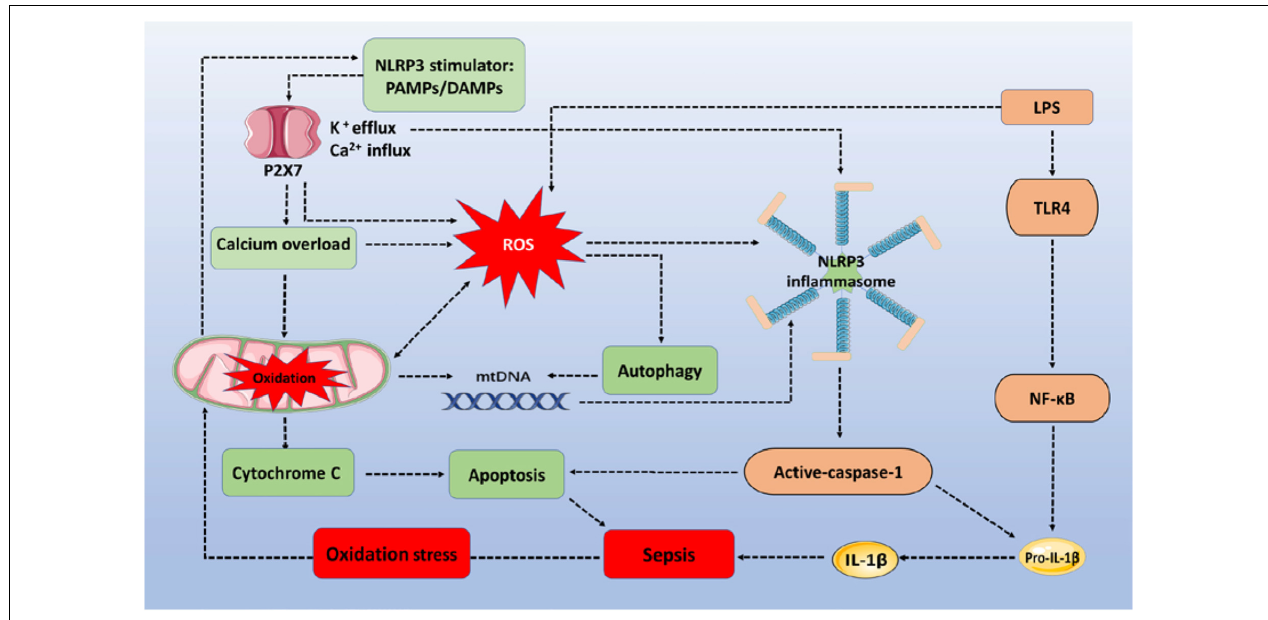
FIGURE 1 | The ROS/NLRP3 signaling pathway participates in sepsis-related immune responses. The sepsis associated oxidative stress induces ROS generation via oxidation of mitochondria. PAMPs/DAMPs trigger P2X7 activation and promote Ca 2 + influx and K + efflux. Increased Ca 2 + influx (calcium overload) and ROS destroy the stability of mitochondria, triggering mtDNA and cytochrome C accumulation within the cytoplasm, to assemble NLRP3 inflammasomes and induce apoptosis. LPS activates TLR4/NF- κ B signaling to express pro-IL-1 β and pro-IL-18. Activated caspase-1 then cleaves pro-IL-l β and pro-IL-18 into their mature forms to increase the inflammatory response. In addition, NLRP3 inflammasomes depend on caspase-1 to mediate immune cell apoptosis. During the whole process, autophagy is activated by ROS to clear mtDNA, and to partially reduce NLRP3 inflammasome activation. ROS, reactive oxygen species; NLRP3, NOD-, LRR-, and pyrin domain-containing protein 3; TLR4, toll-like receptor 4; LPS, lipopolysaccharides; PAMPs/DAMPs, pathogen-associated molecular patterns and damage-associated molecular patterns; mtDNA, mitochondrial DNA.